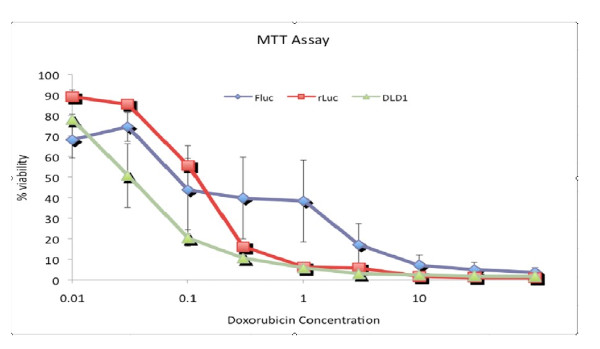
MTT assay result; The effects of Doxorubicin on DLD-1, DLD1/SV-rLuc, and DLD1/SV-FLuc cells exposed to serial dilution of Doxorubicin ranging from 10 ηM to 100 μM for 96 hours showing gradual decrease in % viability with the increasing dose of Doxorubicin. Absorbance values were blanked against DMSO and the absorbance of cells exposed to medium only (i.e. no Drug added) was taken as 100% cell viability.